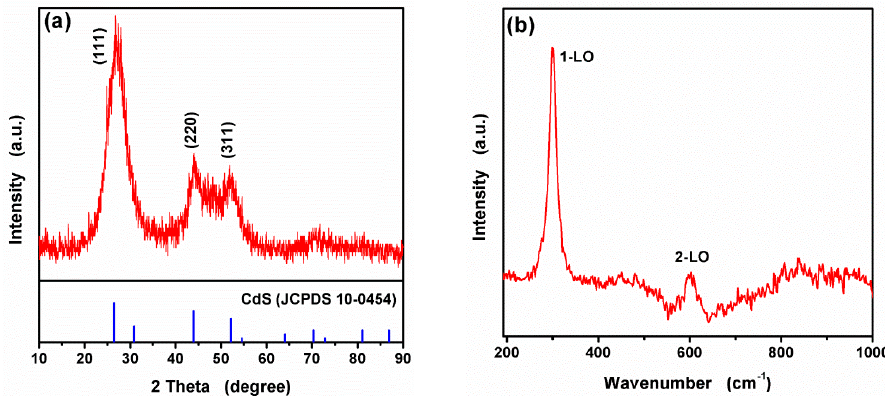
Figure 1. X-ray diffraction pattern ( a ) and Raman spectra ( b ) of as-synthesized CA-CdS QDs.